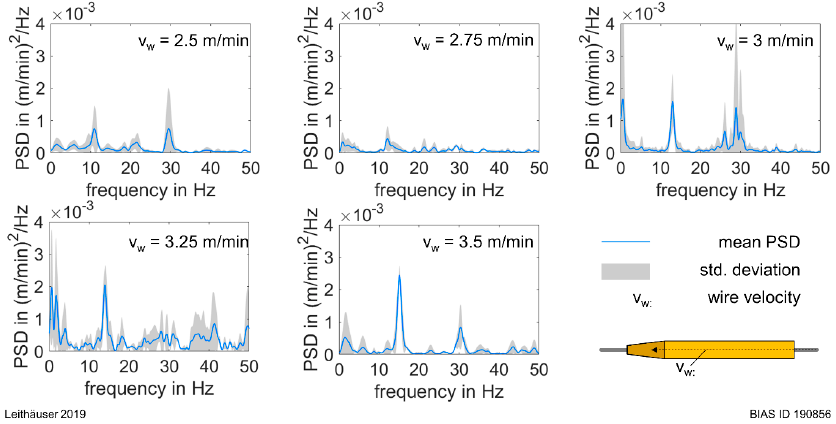
Figure 11. Mean PSDs and standard deviations of the wire velocity for wire feed rates between 2.5 and 3.5 m/min.